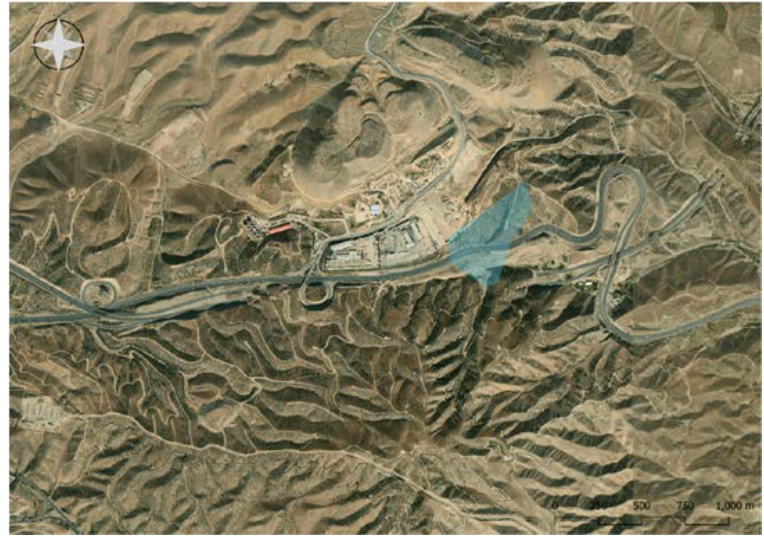
Fig. 3: The location of the Malek Shen sand recycling factory